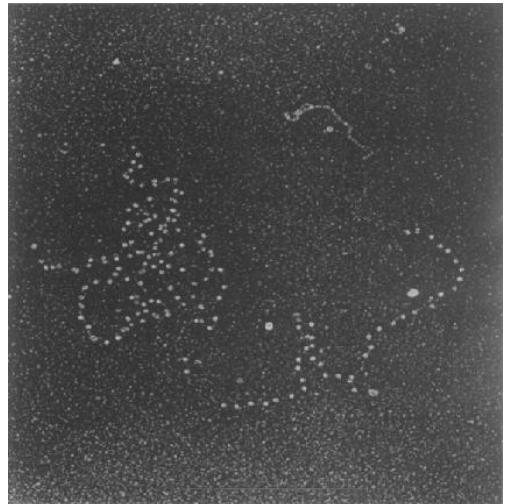
Figure 1. Visualising DNA molecules using electron microscopy. An electron micrograph generated by shadow-casting electron microscopy of multiple DNA polymerase proteins bound to individual DNA molecules (reproduced with permission from [11]).